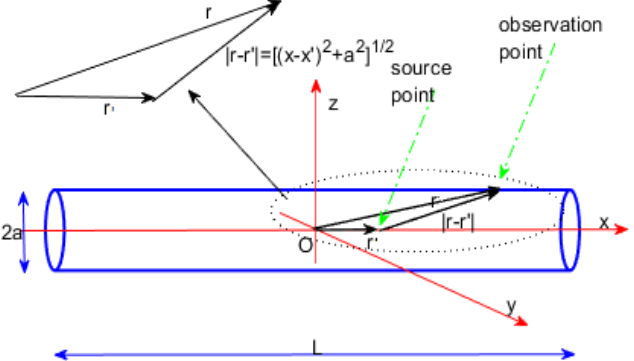
Figure 1. Cylinder with length L and radius a . r (cid:48) and r are the position on which the potential φ (observation point) is evaluated and the position of the charge distribution on the cylinder, respectively (source